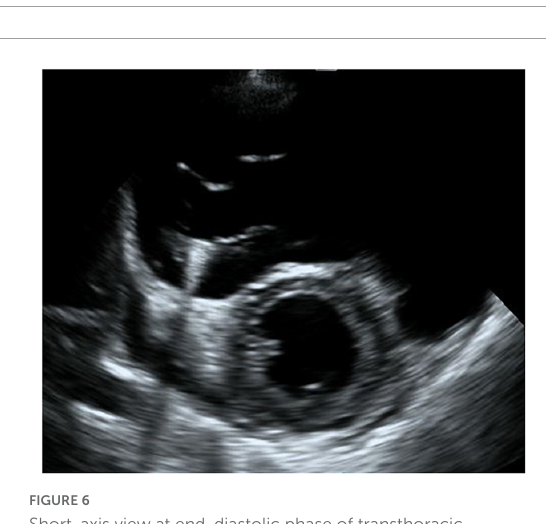
FIGURE6 Short-axis view at end-diastolic phase of transthoracic echocardiography in Case 3. Note that the right ventricle is much larger than the left ventricle, and the left ventricle is very small.